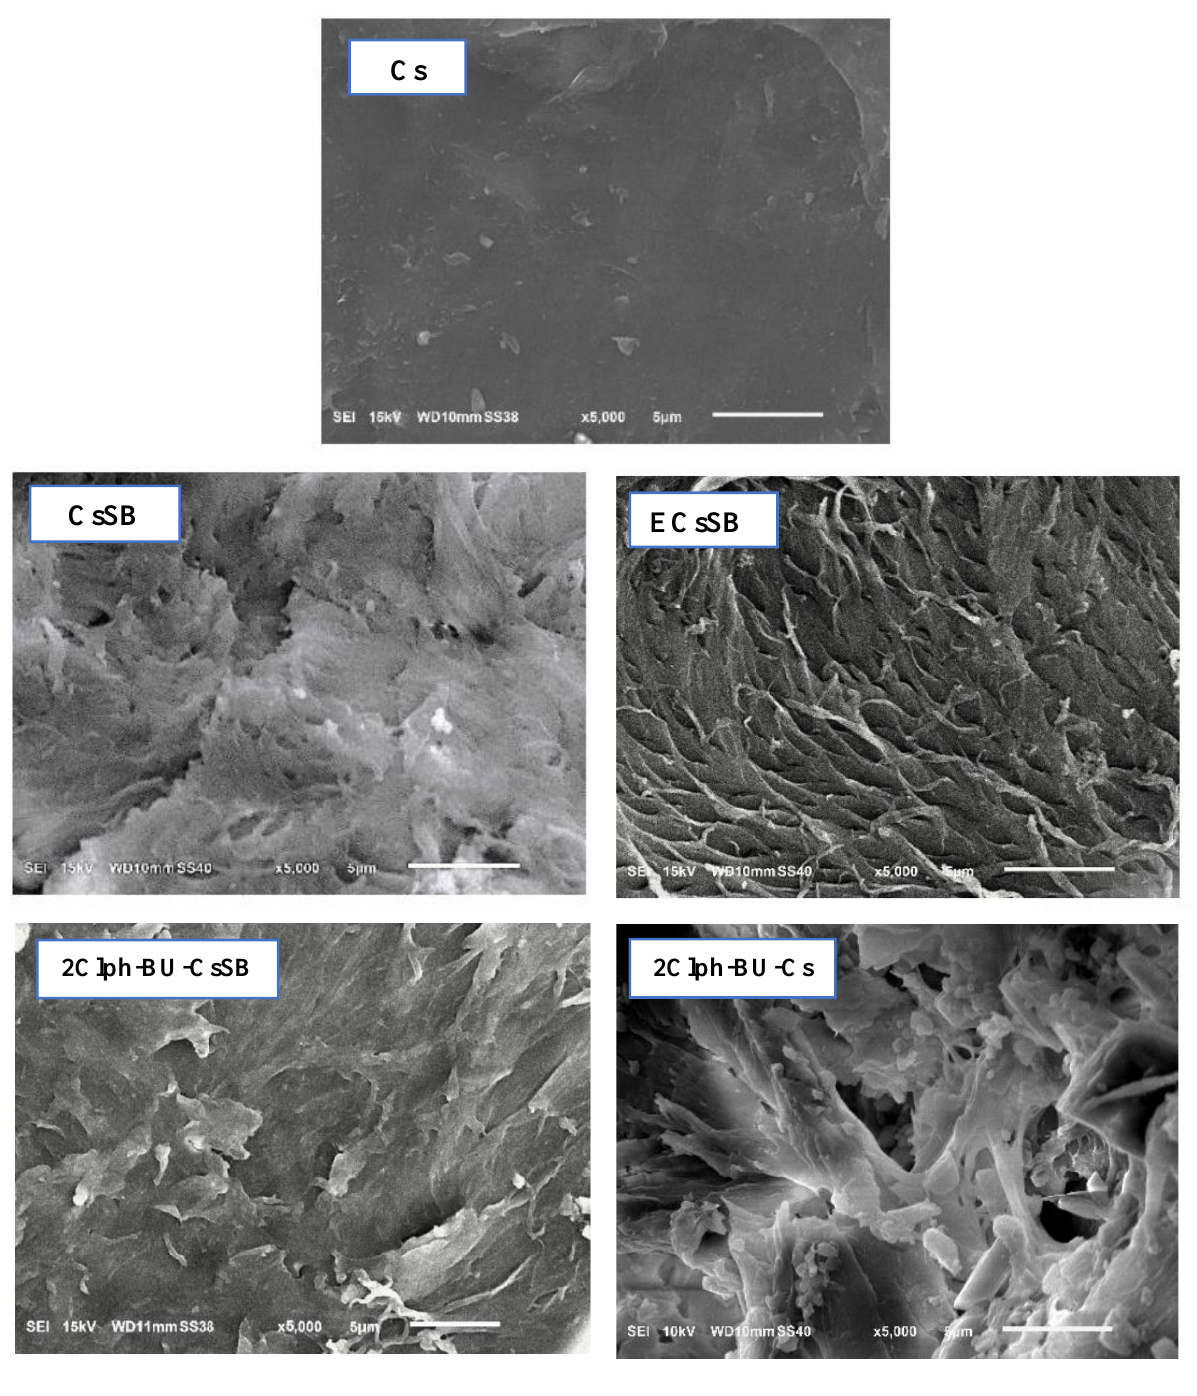
Figure 5. SEM images of 2Clph-BU-CsSB and 2Clph-BU-Cs adsorbent.